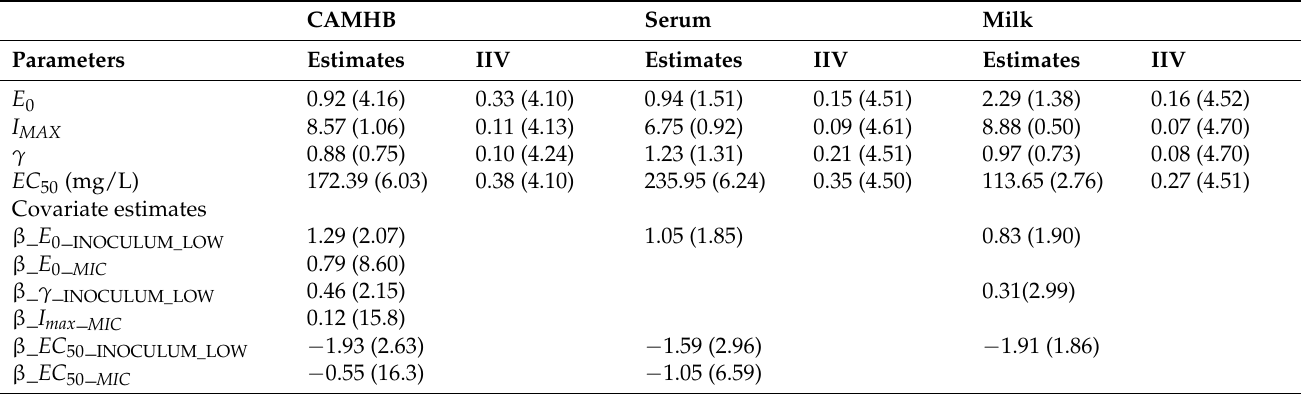
Table 4. Final parameters from inhibitory I MAX model obtained after time kill curves simulated with one population bacterial model for each growth medium used. Data presented as estimates with % RSE, including inter-individual variability (IIV).